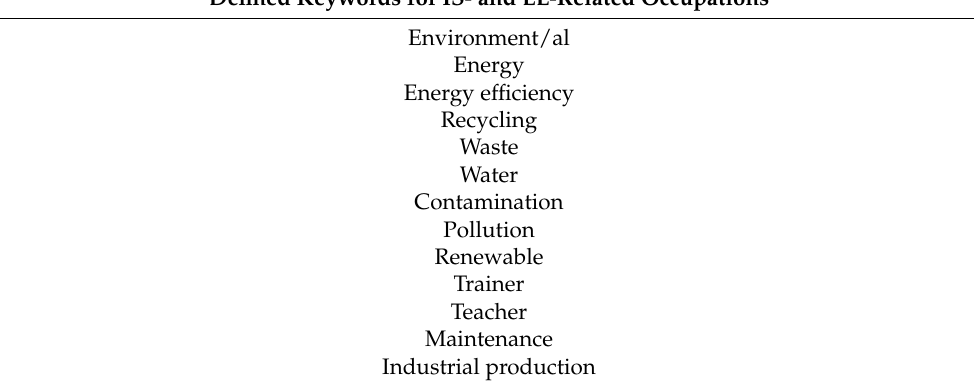
Table 1. The keywords to identify IS- and EE-related transversal job profiles in the manufacturing industry in the ESCO database. Defined Keywords for IS- and EE-Related